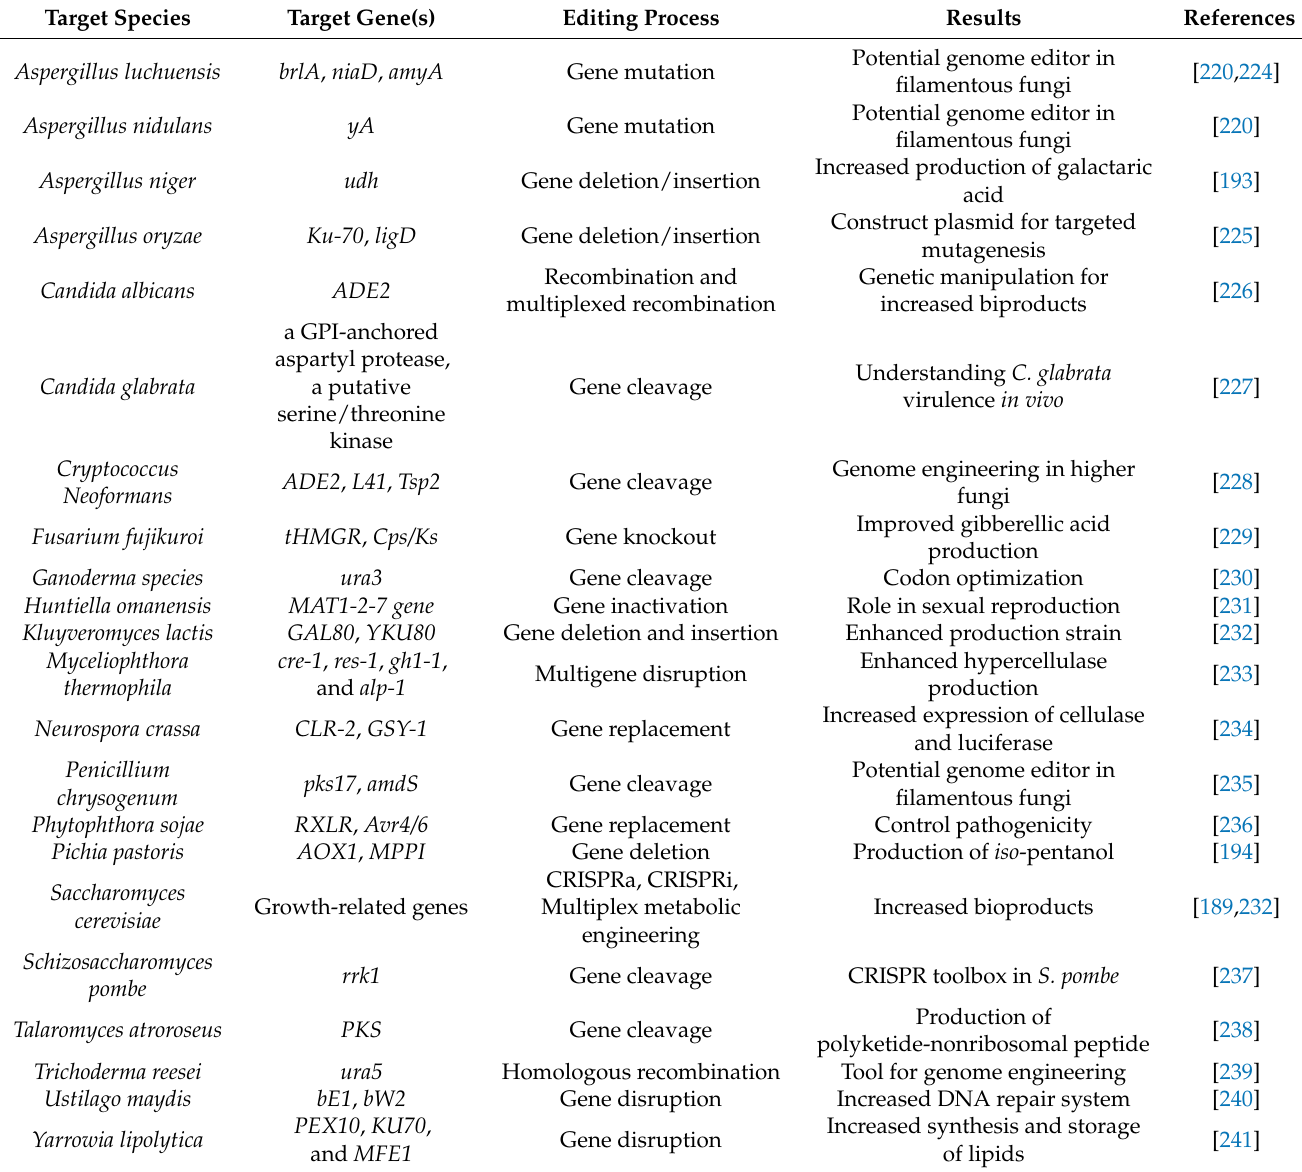
Table 8. The application of CRISPR–Cas in the food industry. Abbreviations: CRISPRi, CRISPR interference; GFP, green fluorescent protein; MUCICAT, multicopy chromosomal integration using CRISPR-associated